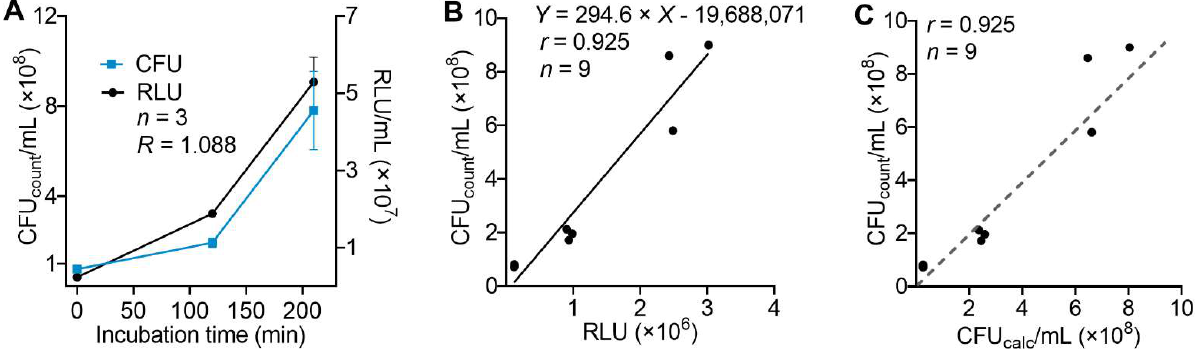
Figure 2. Correlation of luminescence-based readout and bacterial density as determined by colony counting. ( A ) E. coli suspended in 50% BHI broad medium were incubated at 37 °C, 5% CO 2 , and CFU count /mL were determined by spreading aliquots on agar plates and counting bacterial colonies after 20 h. In parallel, bacterial density was determined on the basis of ATP-dependent luminescence in bacterial lysates. The bacterial growth rate (R) was defined as the logarithm of RLU 210 to the base of RLU 120 , assuming exponential growth (similar to that obtained on basis of CFU count ). ( B ) Linear correlation between luminescence values as relative luminescence units (RLU) and bacterial density determined as CFU count /mL. Luminescence detected in bacterial lysates from samples heat-inactivated at t = 0 min were set to zero CFU/mL. ( C ) Comparability of recalculated bacterial density (CFU calc /mL) to manually counted bacterial density (CFU count /mL) of ESBL E. coli . To calculate bacterial density in aPDI experiments after incubation, the detected raw RLU data had to be adapted before further calculation, accounting for the bacterial growth rate (R): RLU adapt = ( RLU PDI ) 1/ R